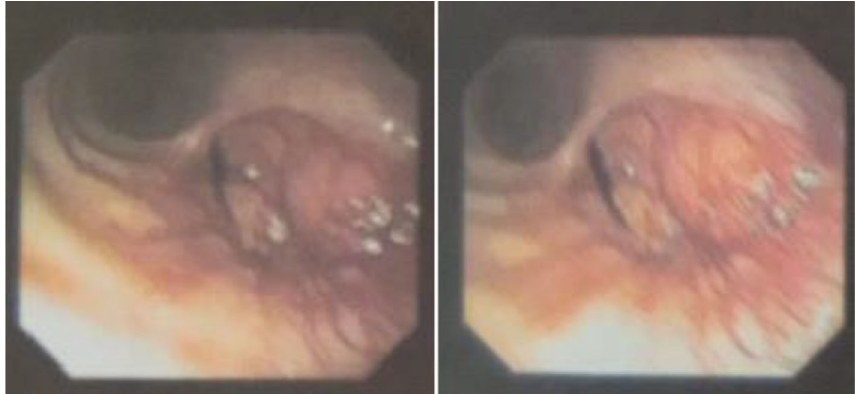
Figure 1: Bronchial endoscopy revealed a hypervascularized bud obstructing the left mainstem